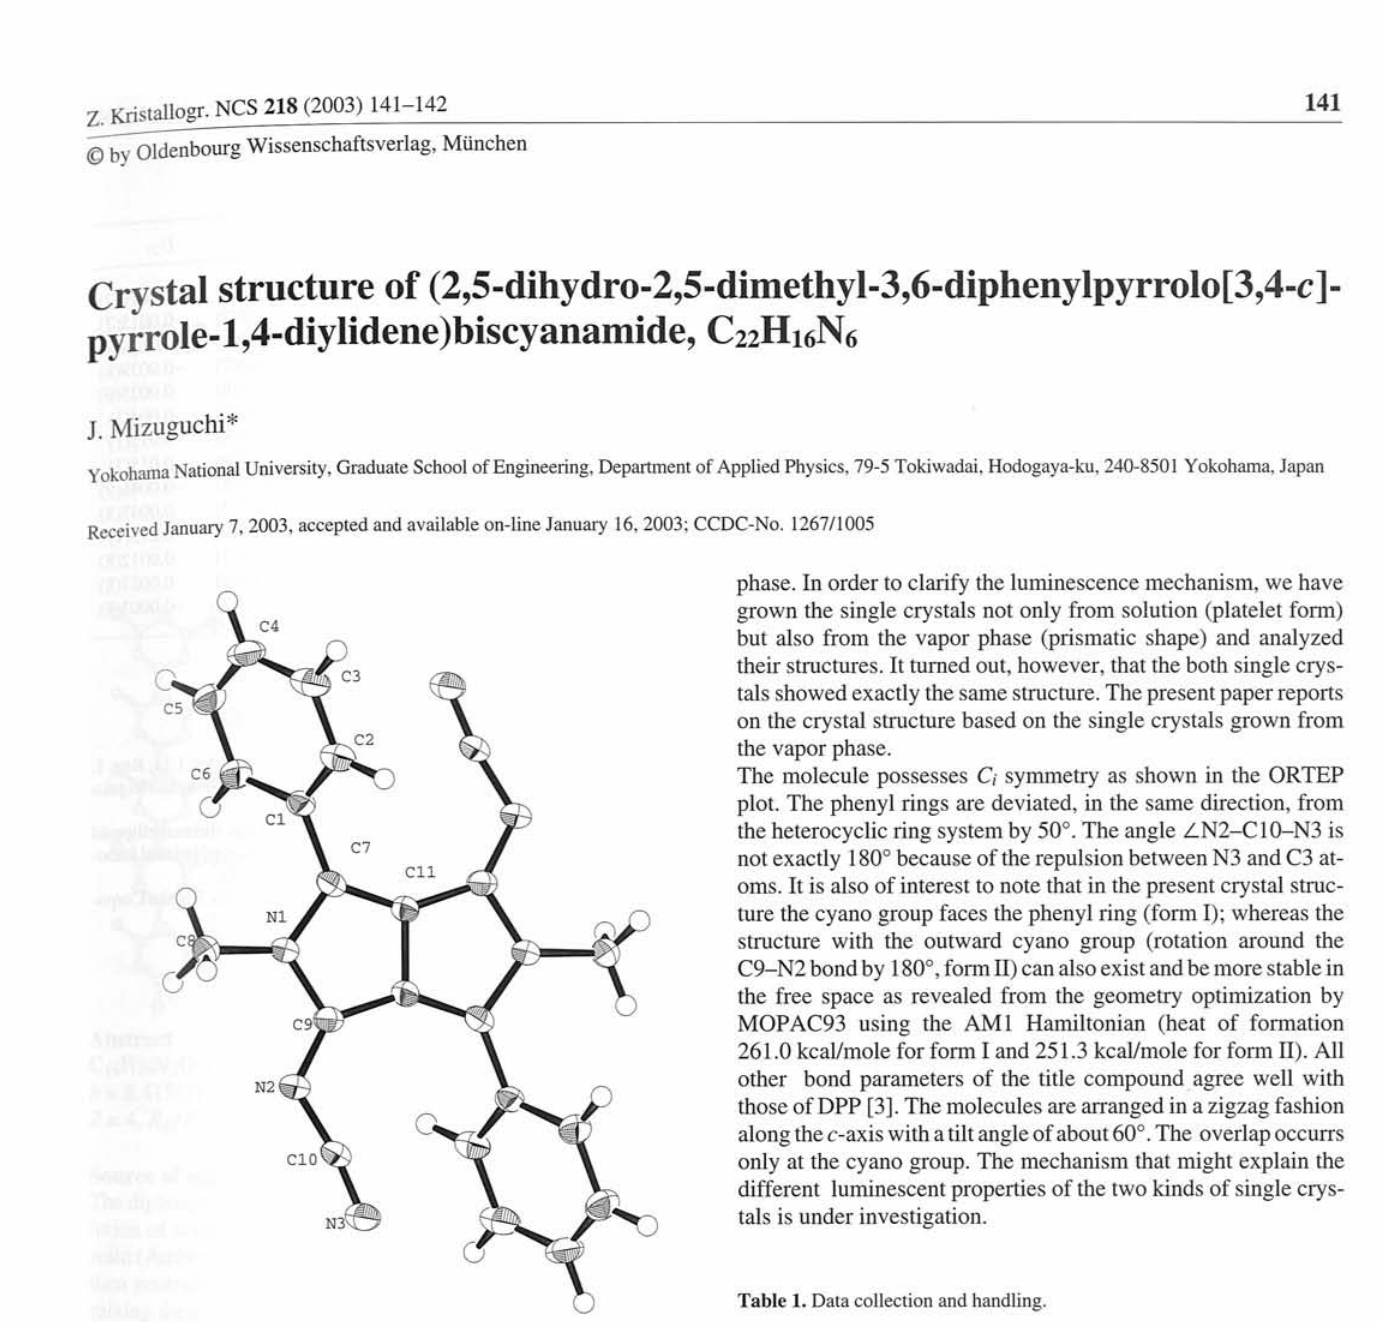
Table 1. Data collection and handling.